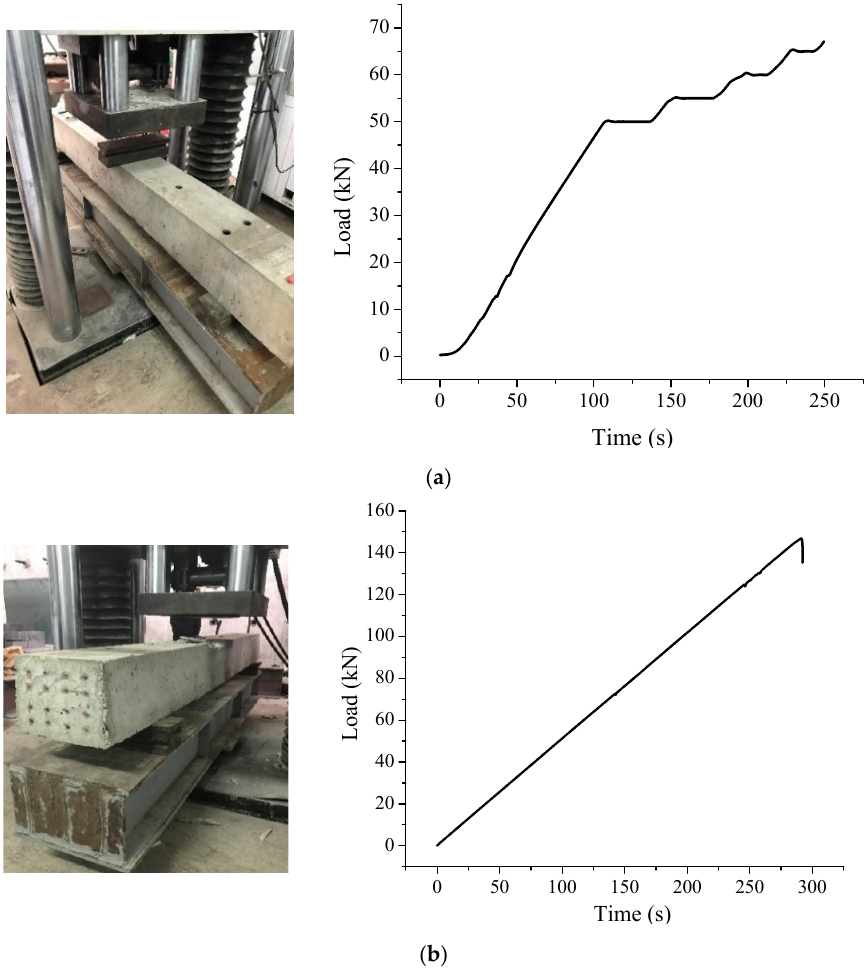
Figure 15. Results of cracking and failure loads. ( a ) Test load for first crack (PSB5); ( b ) Maximum test load